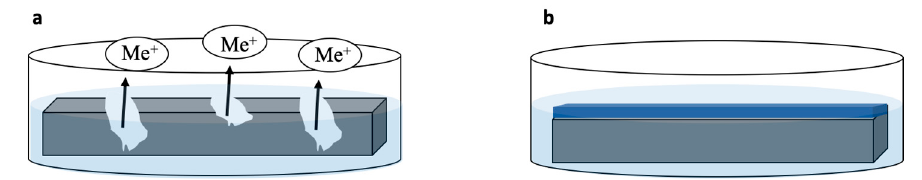
Figure 5. ( a ) Uncoated; and ( b ) sol-gel-coated metal substrates exposed to the aggressive bio-environment. and ( b ) sol-gel-coated metal substrates exposed to the aggressive